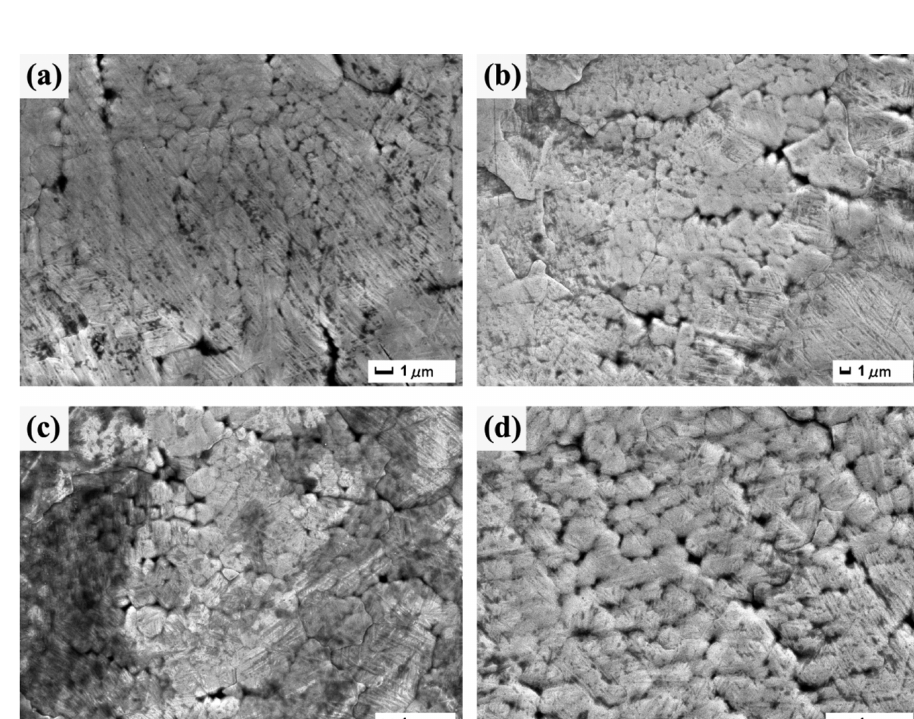
Figure 3: High magnifications of craters on the surface of pure zirconium with: (a) 5 pulses and (b) 10 pulses.